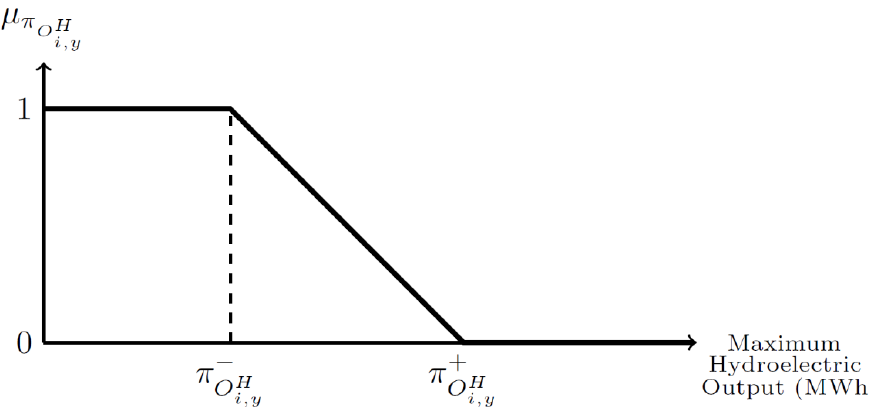
Figure 3. Hydropower generation constraint’s fuzzy membership function.